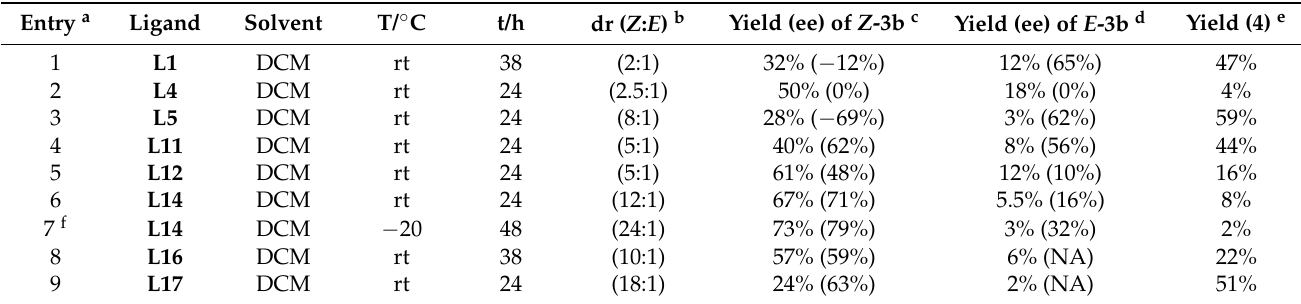
Table 2. Ligands screening for Catalytic Asymmetric [3 + 1]-Cycloaddition Reaction of donor acceptor cyclopropene 5 with 2b a